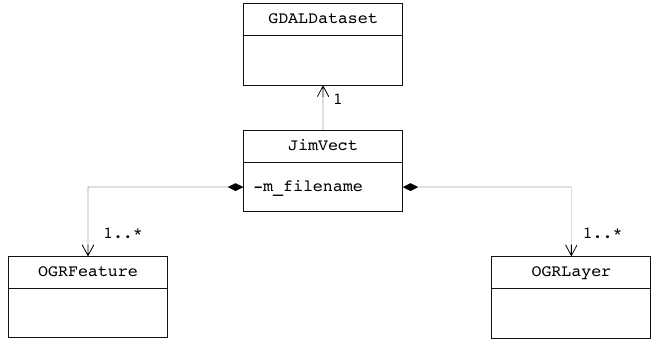
Figure 2. Class diagram for vector